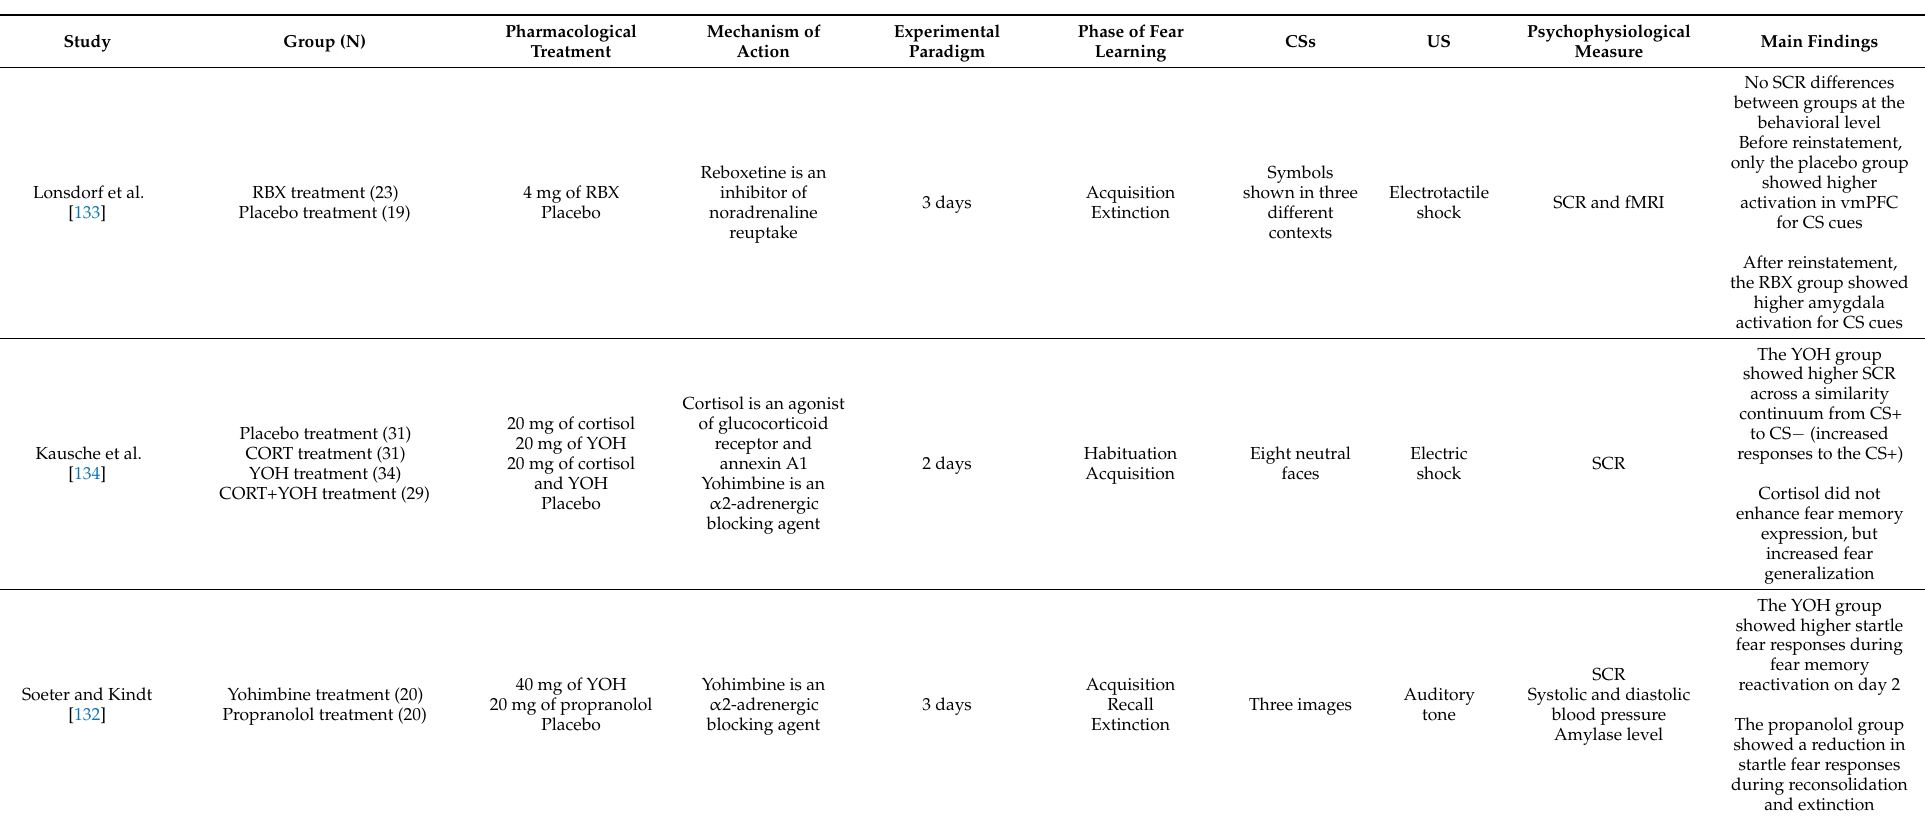
Table 2. Summary of findings in studies with the administration of noradrenaline